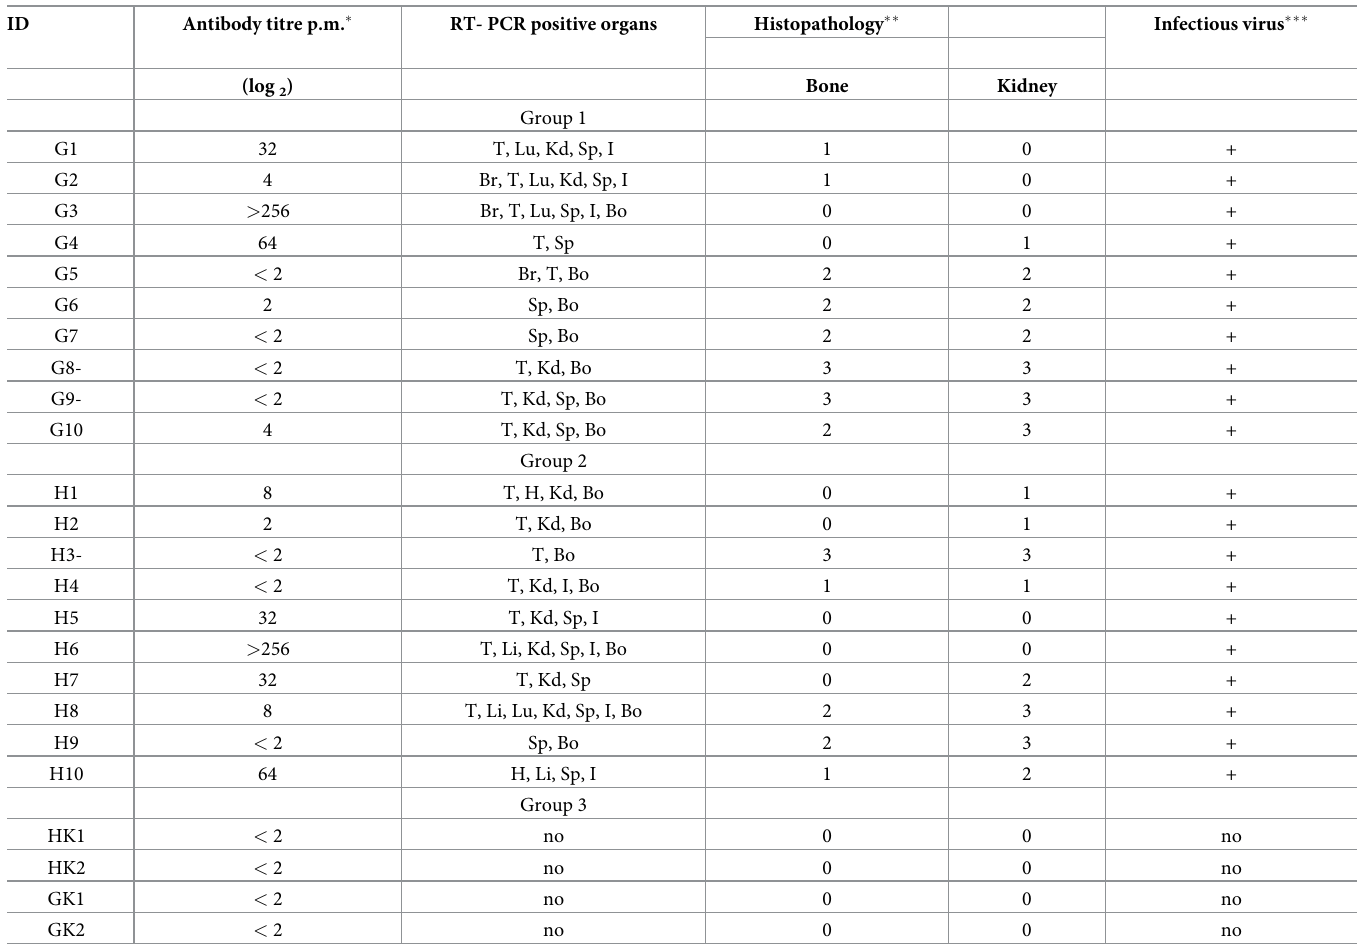
Table 1. Post mortem findings in experimentally tortoise picornavirus infected tortoises. ID Antibody titre p.m.